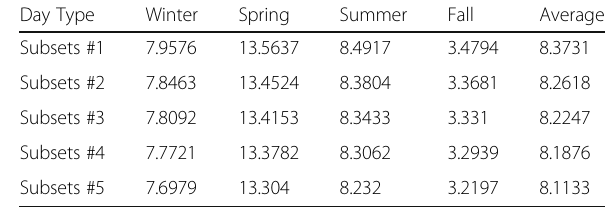
Table 3 Comparison of mape results for different input-data